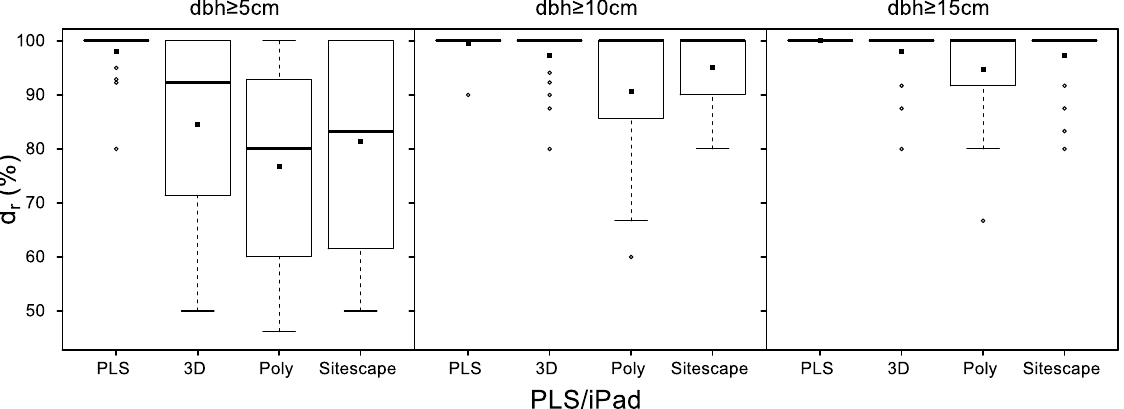
Figure 9. Distribution of detection rates for PLS/iPad and lower dbh thresholds. Black squares represent average detection rates over all sample plots.